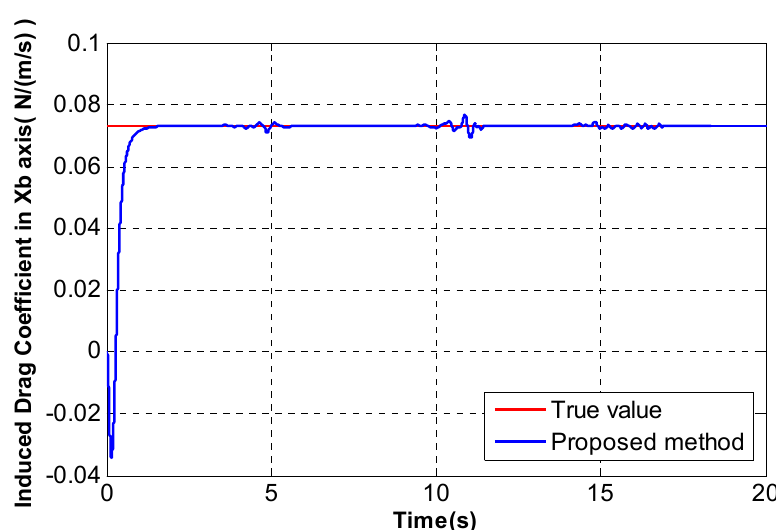
Figure 10. Induced drag coefficient estimation value in Yb axis.